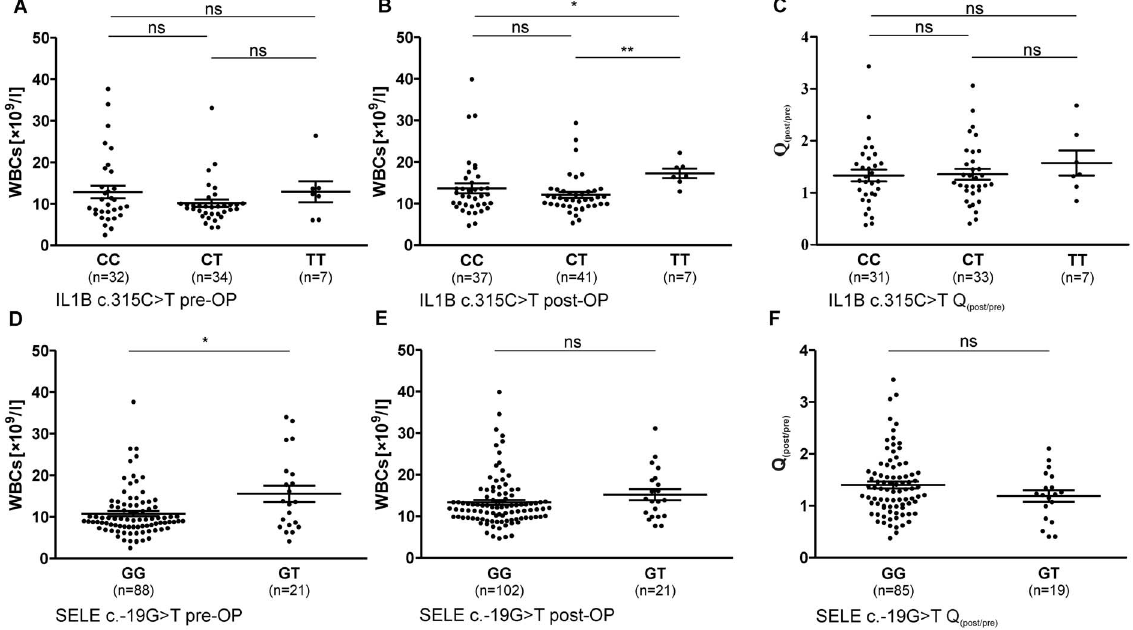
Figure 2. Pre- and postoperative WBC counts (mean ± SEM), as well as factorial change Q (post/pre) of WBCs in the course of surgical intervention in patient sera (ns: not significant; *=P , 0.05, **=P , 0.005). 2A–C: WBC counts in correlation with IL1B c.315C . T; A: Preoperative WBCs, B: Postoperative WBCs, C: Q (post/pre) of CRP in the course of surgical intervention; 2E–G: WBC counts in correlation with SELE c.- 19G . T; E: Preoperative WBCs, F: Postoperative WBCs, G: Q (post/pre) of CRP in the course of surgical